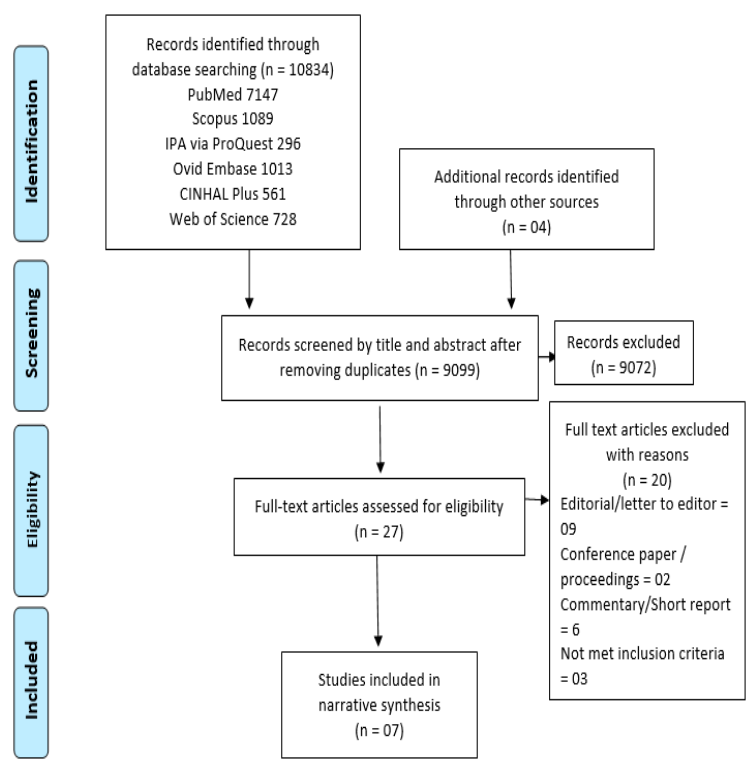
Figure 1. Flowchart of the study inclusion